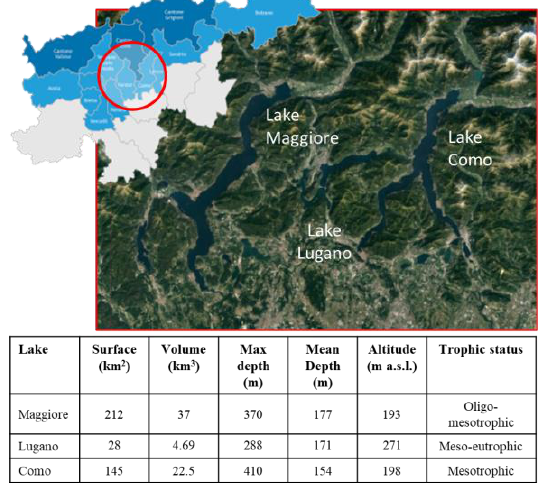
Figure 1. The study area: lakes Maggiore, Lugano and Como, situated in the insubric region, between Italy and Switzerland, and their main characteristics (from Salmaso et al.,